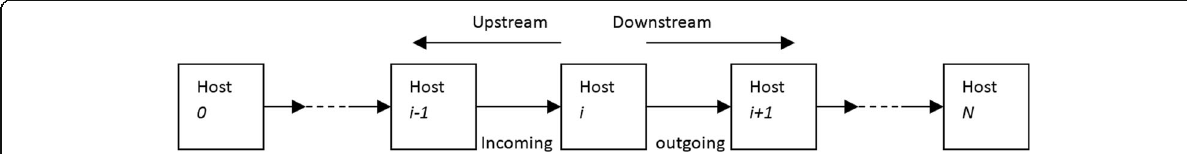
Fig. 1 A sample connection chain. Host 0 is used by an intruder to launch an attack to Host N via compromised hosts Host 1, Host 2,..., Host N − 1. SSID can occur at one of the stepping-stones. It is assumed that the detection program resides in Host i which is called a (detecting) sensor. SSID is to determine whether the sensor Host i is used as a stepping-stone. The connection from Host i − 1 to Host i is called an incoming connection to Host i , and the connection from Host i to Host i + 1 is called an outgoing connection from Host